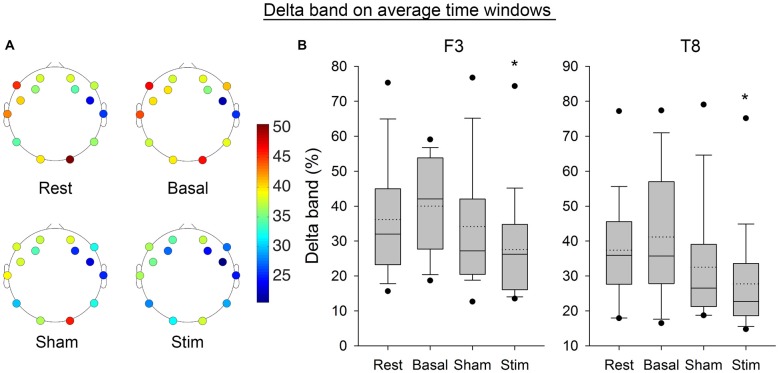
(A) Average EEG Delta band for all subjects per electrode and condition. (B) Boxplot representing the same band for the electrode F3 and T8, from the average of PSD over time windows for all subjects per condition. The boxes correspond to the 25–75 percentiles, the continuous lines are the median values, the dotted lines are the mean values and the whiskers represent the 10 and 90 percentiles. The dots are the outlying values. Note the decrease for the active stimulation condition. The Delta band is expressed in percent of the complete spectrum (%), *p < 0.05 as compared to the three other conditions.